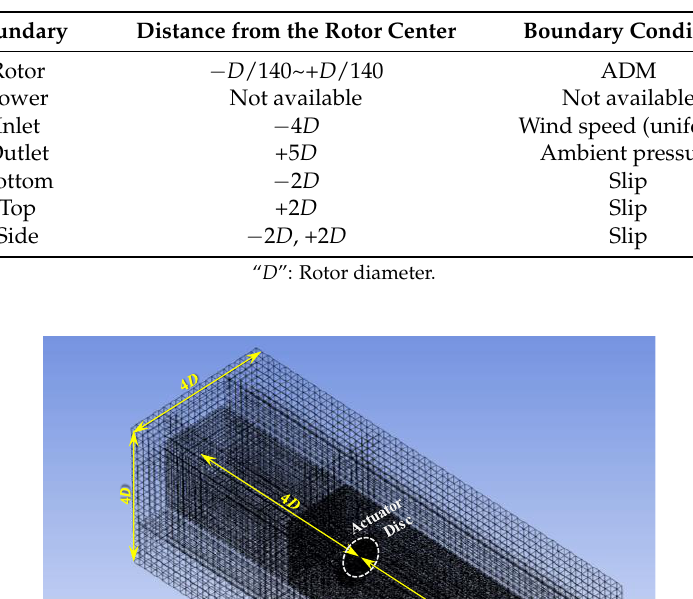
Table 2. Simulation domain and boundary conditions.